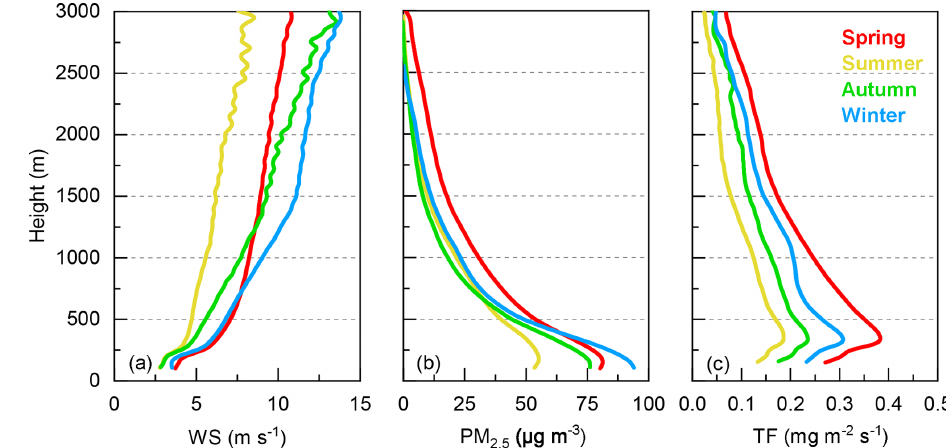
Figure 6. Vertical profiles of WS (a) , PM 2 . 5 (b) and TF of PM 2 . 5 (c) in different seasons in Beijing.